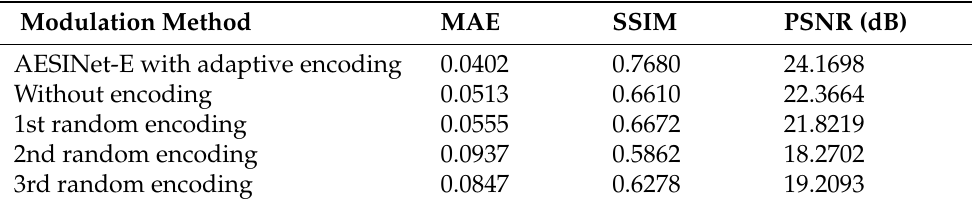
Table 2. AESINet-R reconstruction results with different modulation